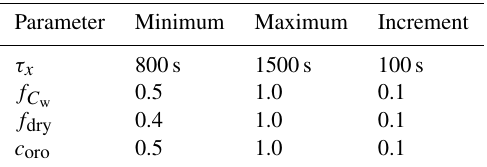
Table 1. Range of values of the free model parameters used for the calibration of the